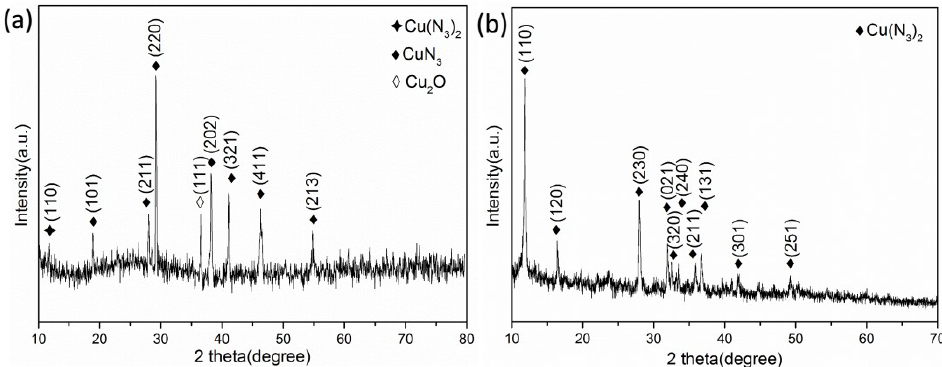
Figure 12. XRD spectra of the azide products of ( a ) the Cu 2 O@CNTs film and ( b ) the Cu@CNTs film .